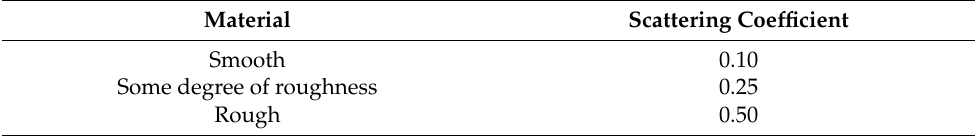
Table 3. Scattering coefficients of the materials used in the acoustic